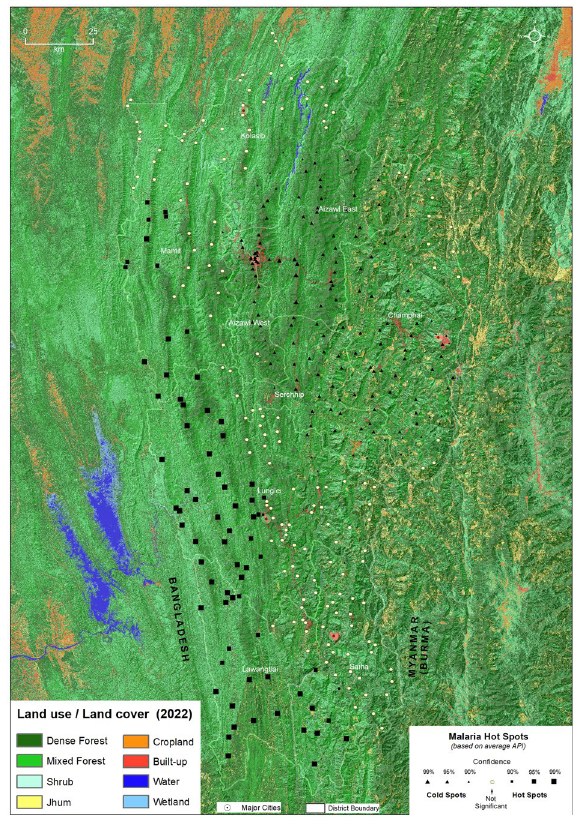
Figure 6. Distribution of the land use/land cover (LU/LC) in Mizoram and adjoining regions in 2022. The LU/ LC classes were extracted from Landsat 8 images extracted from https:// earth explo rer. usgs. gov and are draped over digital elevation model (DEM) of NASA SRTM (Shuttle Radar Topography Mission) Global 30 arc second DEM data available at https:// doi. org/ 10. 5067/ MEaSU REs/ SRTM/ SRTMG L30. 002 for better visualization. The map was created using licensed version of ArcGIS 10.4 software by Esri. For more information about Esri software, please visit www. esri.